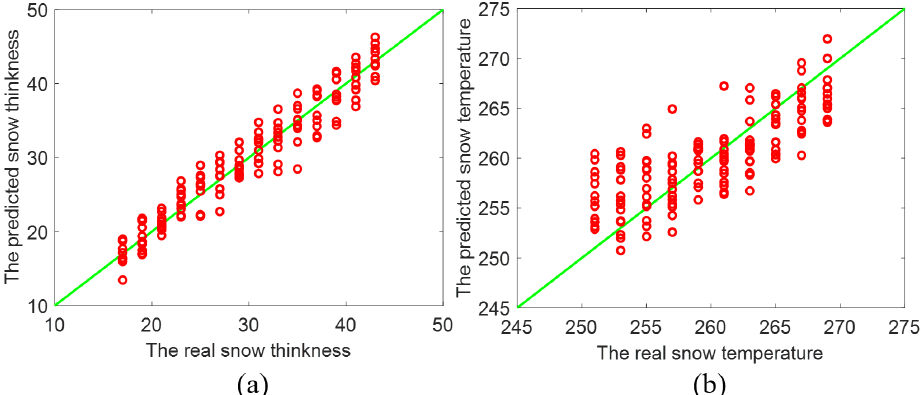
Figure 5. Inverted result of ( a ) the thickness and ( b ) the temperature of the snowpack by the conventional ANN method [14,28].